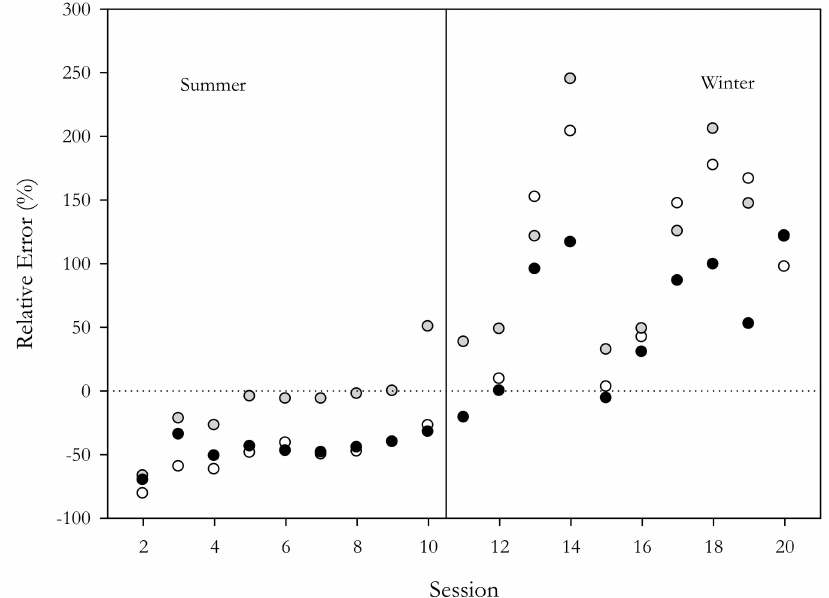
Figure 2. Relative error trend. The abscissa axis x reports the number of monitoring sessions while the ordinate axis y shows the relative error for the different instruments (grey: Aerocet; white: OPC; black: mean of ABx) as compared to the gold standard (gravimetric method).